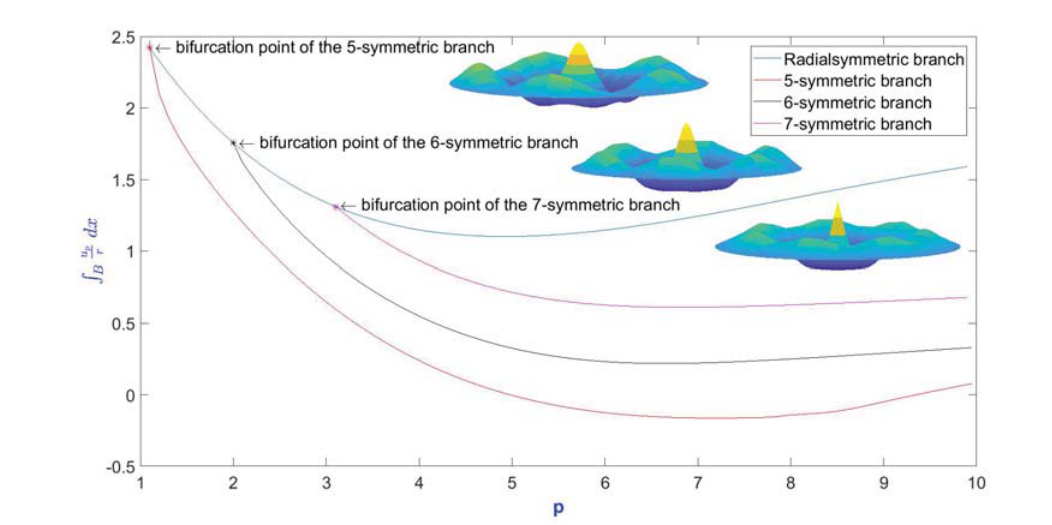
Fig. 12: Bifurcation diagram of the numerical solutions with three nodal